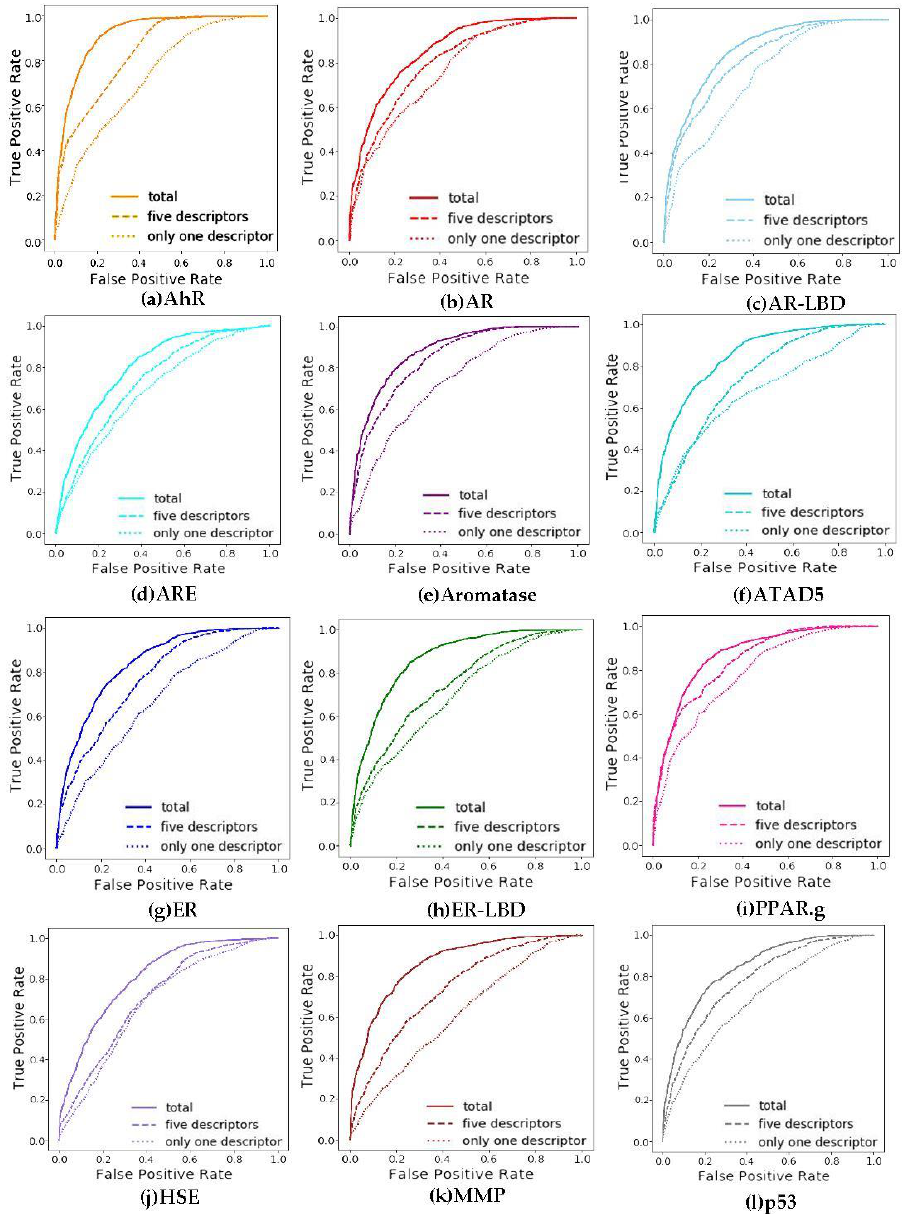
Figure 8. The receiver operating characteristic (ROC) curves of the 12 properties. ( a ) ROC curves of AhR, ( b ) ROC curves of AR, ( c ) ROC curves of AR-LBD, ( d ) ROC curves of ARE, ( e ) ROC curves of Aromatase, ( f ) ROC curves of ATAD5, ( g ) ROC curves of ER, ( h ) ROC curves of ER-LBD, ( i ) ROC curves of PPAR.g, ( j ) ROC curves of HSE, ( k ) ROC curves of MMP, ( l ) ROC curves of p53.